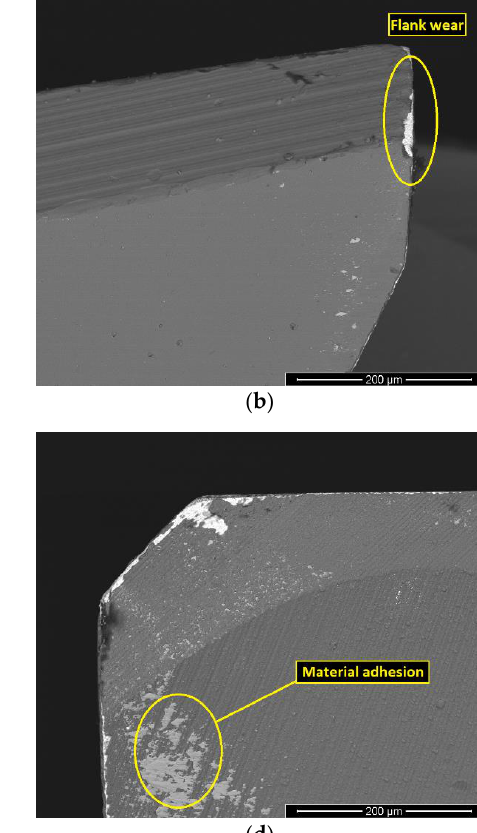
Table 15. VB values obtained from measurements performed on the clearance faces of T4 tools. Tool Ref.